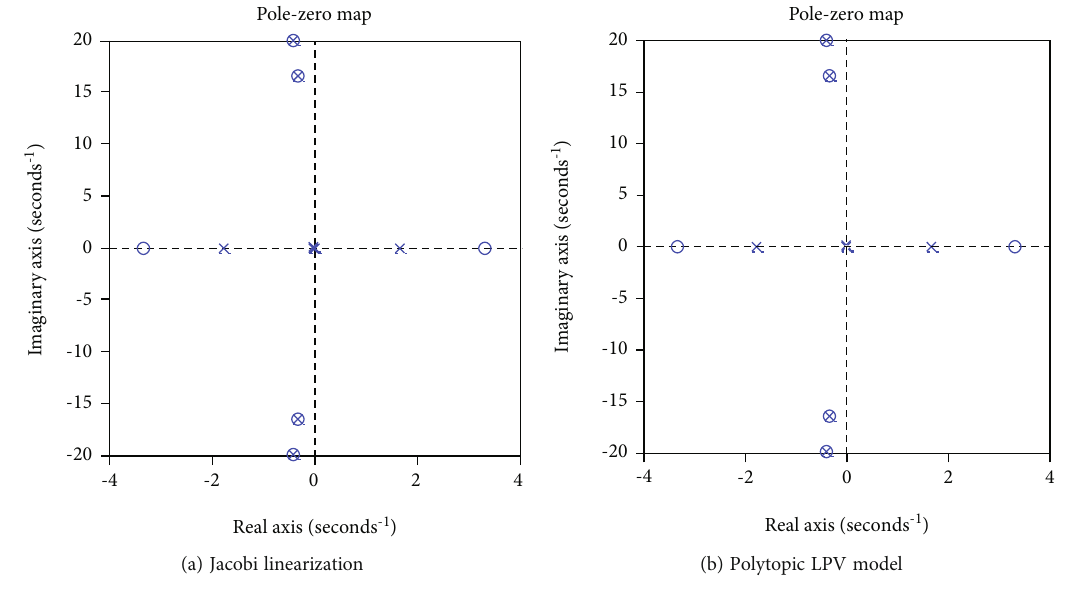
Figure 3: Zero-pole comparison diagram.